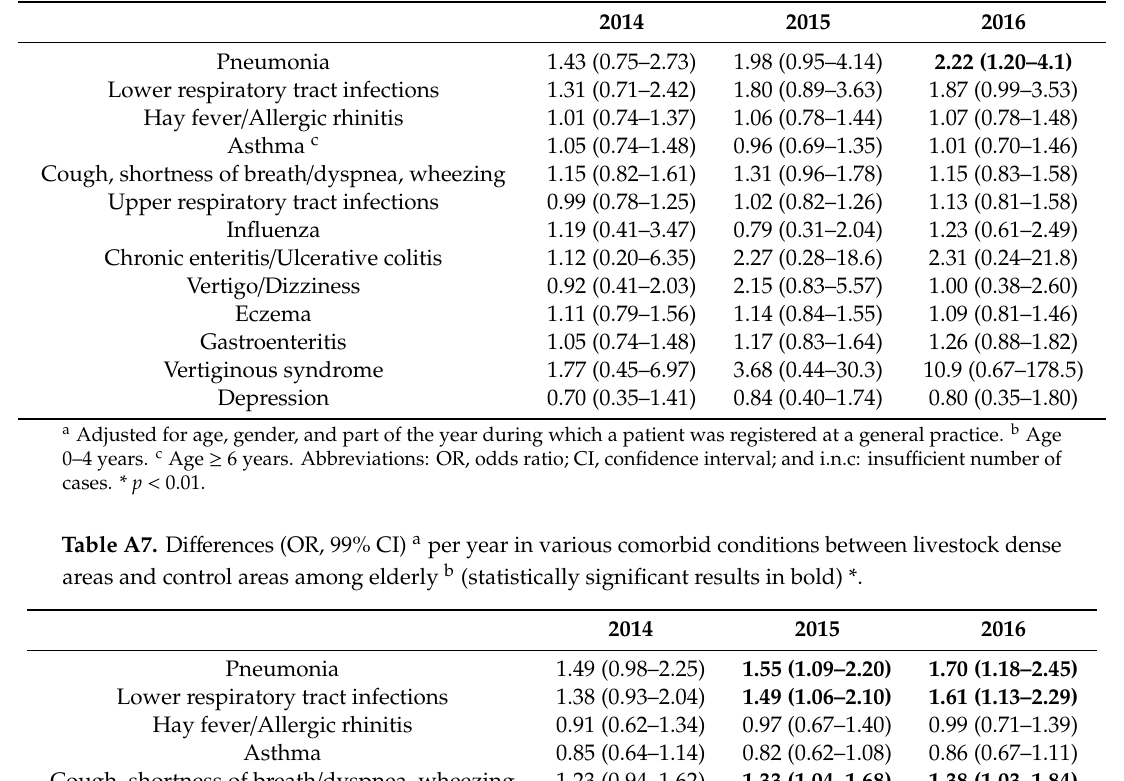
Table A6. Di ff erences (OR, 99% CI) a per year in various comorbid conditions between livestock dense areas and control areas among children b (statistically significant results in bold) *